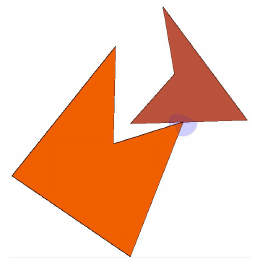
Figure 13: A problematic case where two polygons meet at a point that is on the boundary of both. However their relation is calculated as ’overlap’ according to our algorithm.